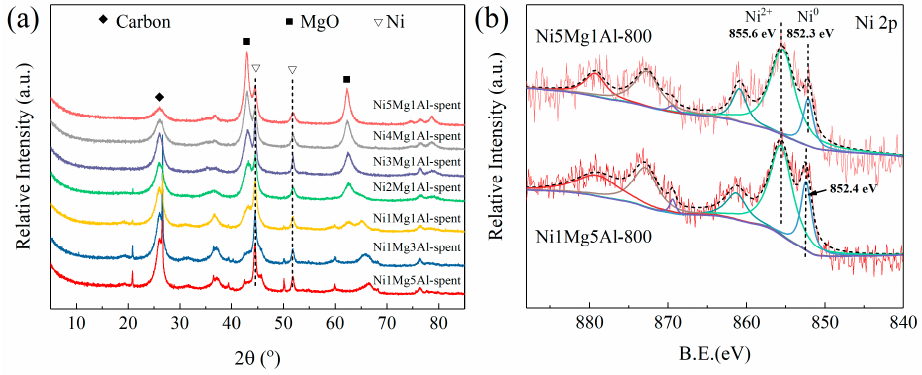
Figure 7. ( a ) XRD patterns and ( b ) Ni 2p XPS spectra of spent Ni x Mg y Al-800 catalysts.